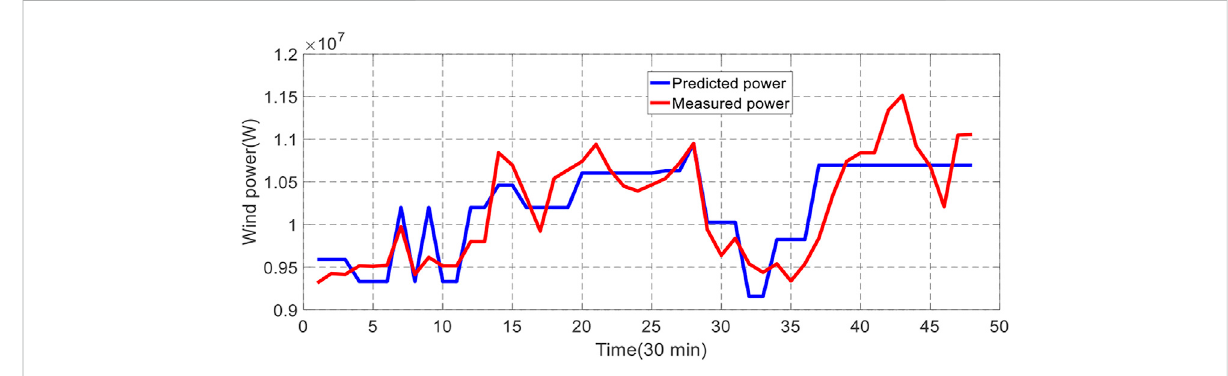
FIGURE 8 Wind power generation prediction (1 day).